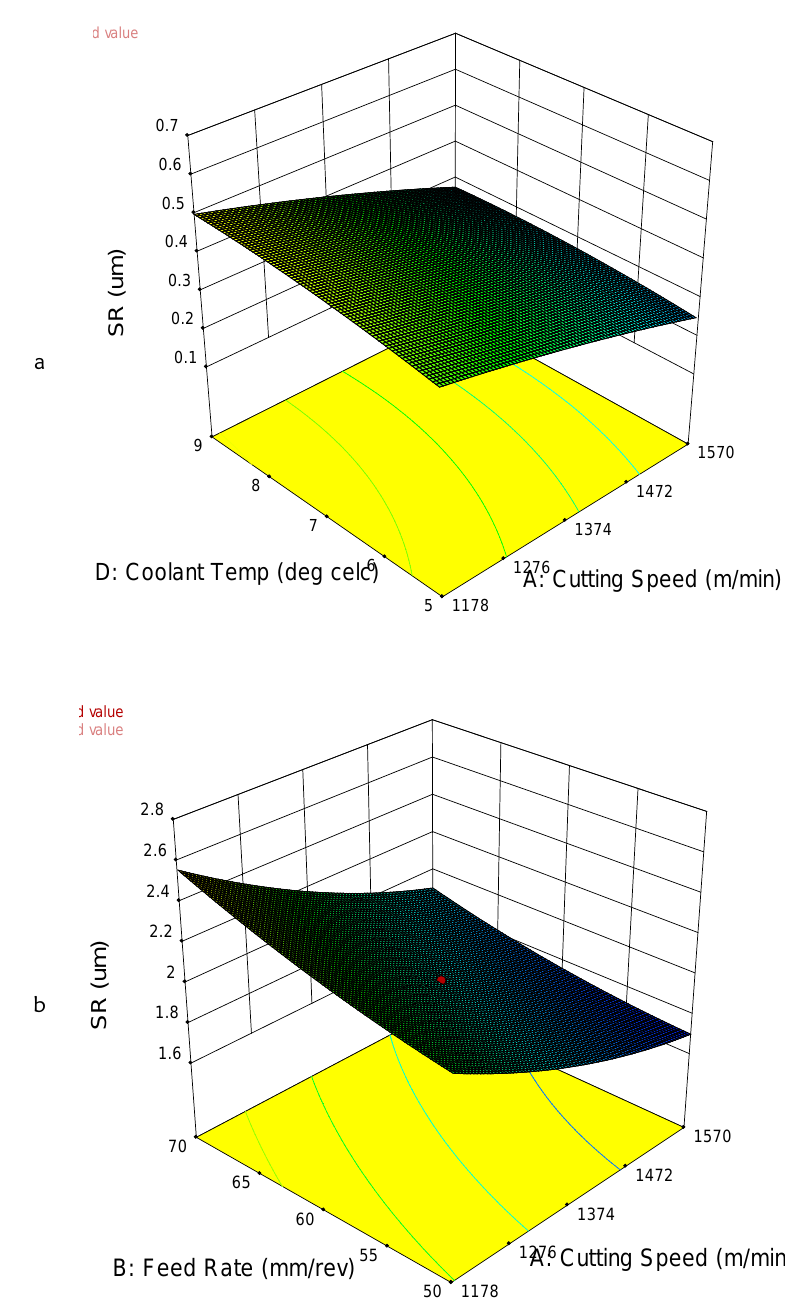
Figure 4: Response surface and contour plot for (a) dry machining and (b) cooled